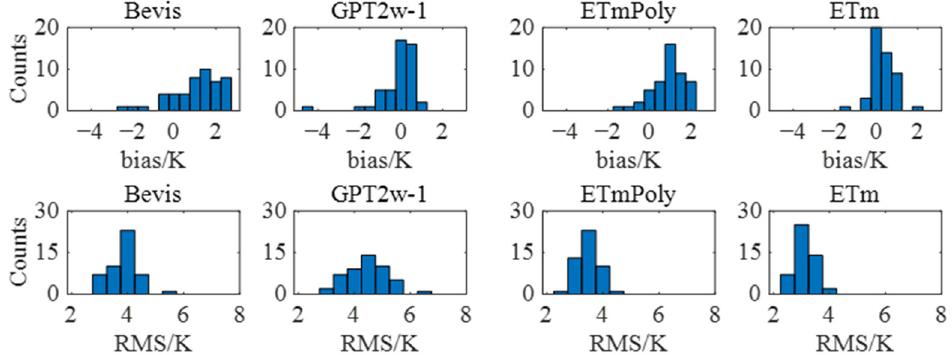
Figure 5. Histogram of bias and RMS values for four Tm models using modeling radiosonde data in 2021 .